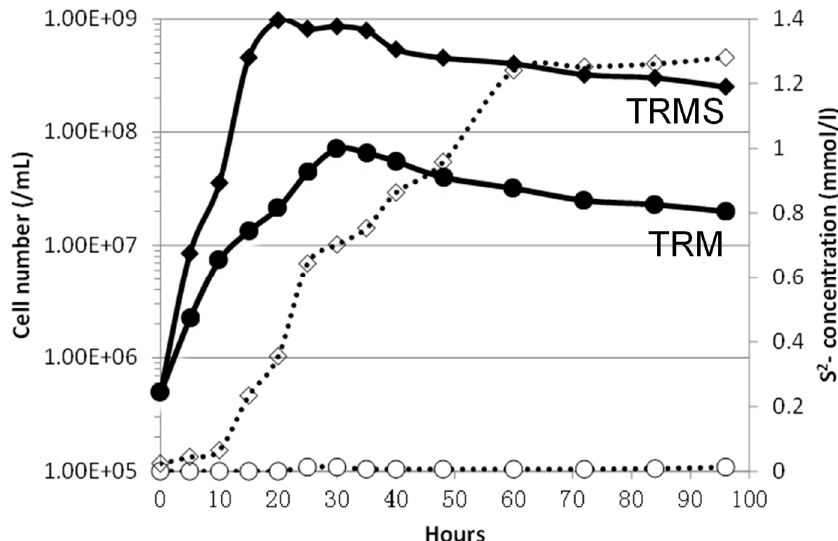
Figure 1. Palaeococcus pacificus DY20341 T cultured with or without elemental sulfur (S 0 ). Data show the growth (solid line) and sulfide production (dotted line) of strain DY20341 cultured in Thermococcales rich medium with the elemental sulfur ( ◆ TRMS medium) and without ( ● TRM medium).